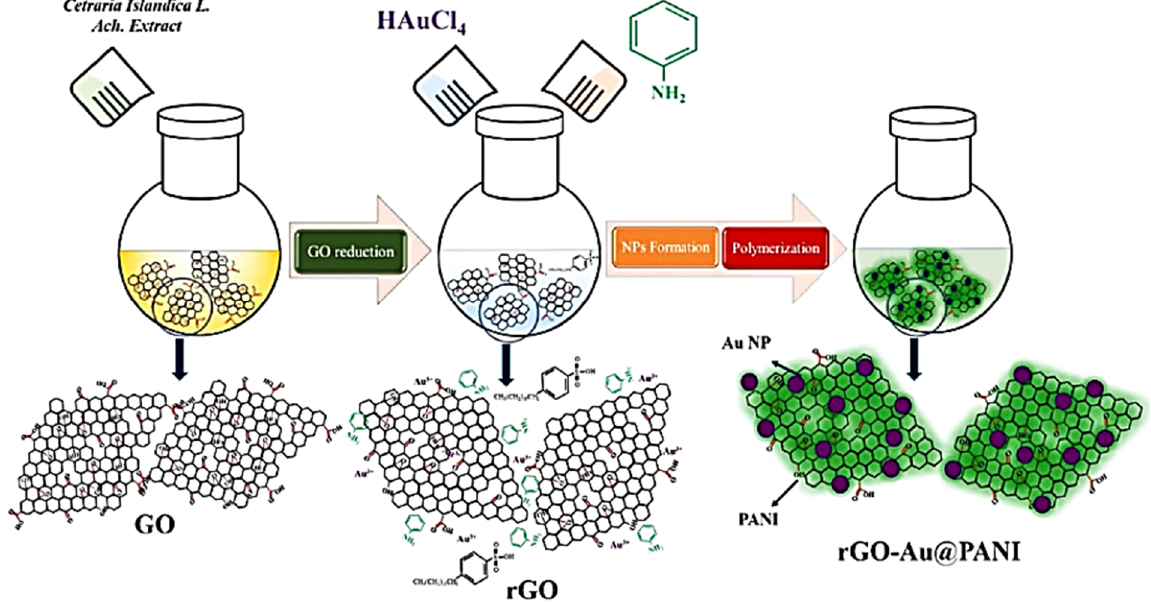
Figure 5. Schematic representation of the preparation of rGO-Au@PANI nanocomposite [118]. rGO-Au@PANI = reduced graphene oxide-gold nanoparticle@polyaniline. Reproduced with permission from Elsevier.